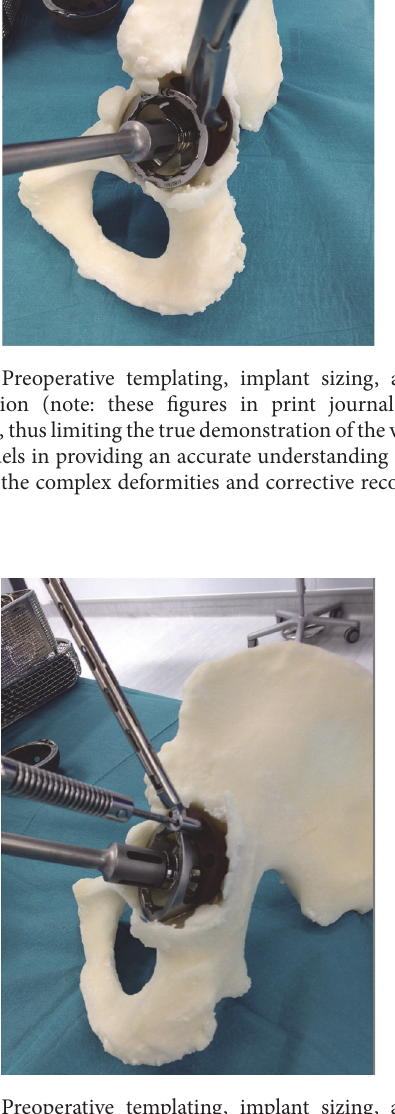
Figure 15: Preoperative templating, implant sizing, and surgi- cal stimulation (note: these figures in print journal are two- dimensional, thus limiting the true demonstration of the value of 3D printed models in providing an accurate understanding and repre- sentation of the complex deformities and corrective reconstructive techniques).